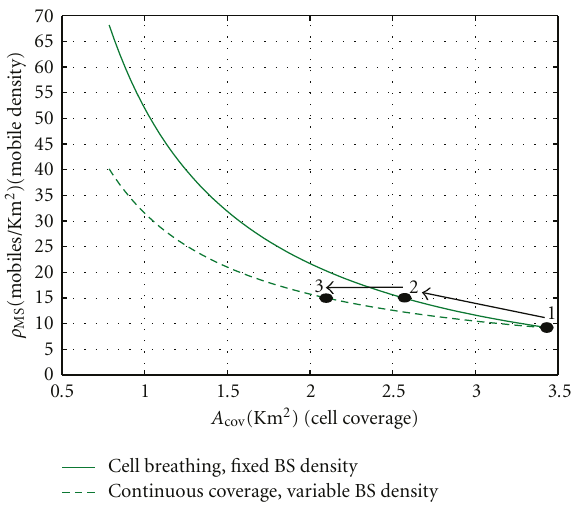
Cell breathing, fixed BS density Continuous coverage, variable BS density Figure 12: Cell breathing (fixed BS density) and BS densification (variable BS density) in a cellular